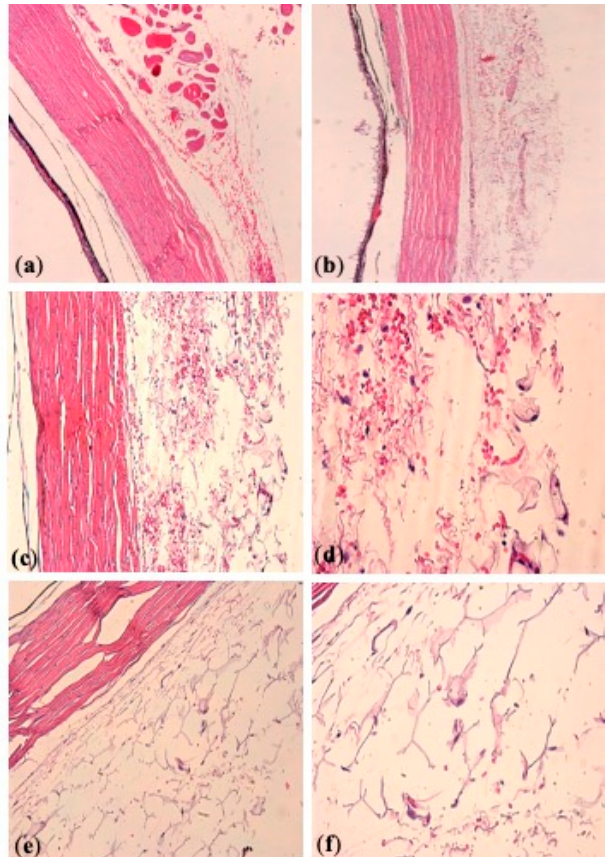
Figure 9. Histopathologic analysis of episcleral tissue injection site, after sub-Tenon injection of Dx-microspheres in phosphate-buffered saline (PBS) (left eye, a , b ) and control eye (right eye, c – f ). ( a , b ) Untreated eyes of two different rabbits, showing absence of tissue reaction; ( c , d ) Dx-microparticle-treated eye (rabbit 1), showing presence of occasional foamy macrophages and no microsphere residues; ( e , f ) Dx-microsphere-treated eye (rabbit 2), showing presence of single foamy macrophages and scattered occasional microspheres residues. Magnification: 10× ( a , b ); 20× ( c , e ); 40× ( d , f ). Table 6. Scored histopathological evaluation at 42 days after sub-Tenon injection of Dx-micro- spheres in PBS (left eye, LE) and control eye (right eye, RE).